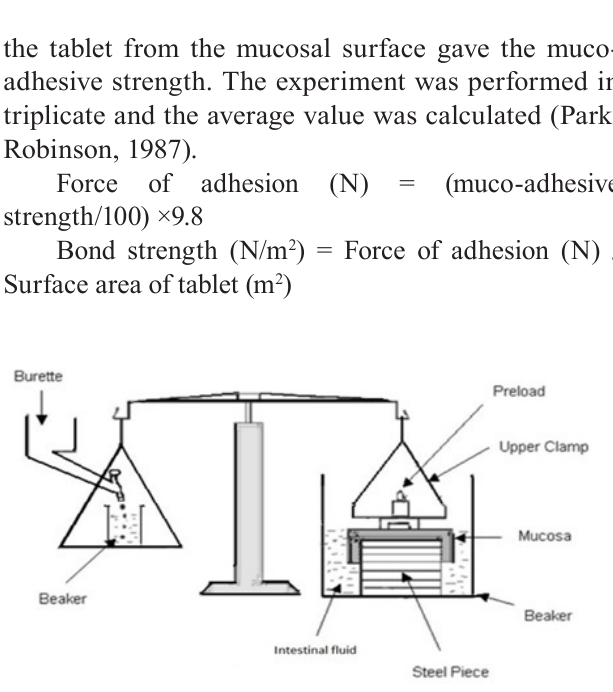
FIGURE 1 - Muco-adhesive strength measurement